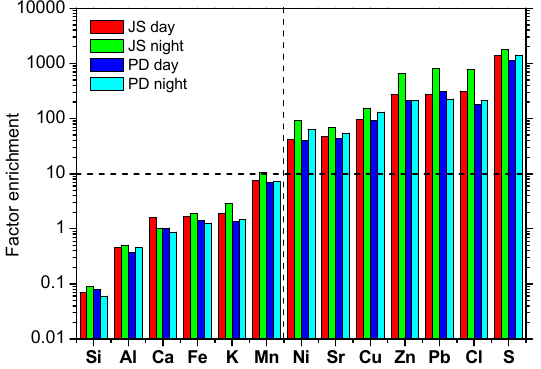
Figure 5. Enrichment factors of